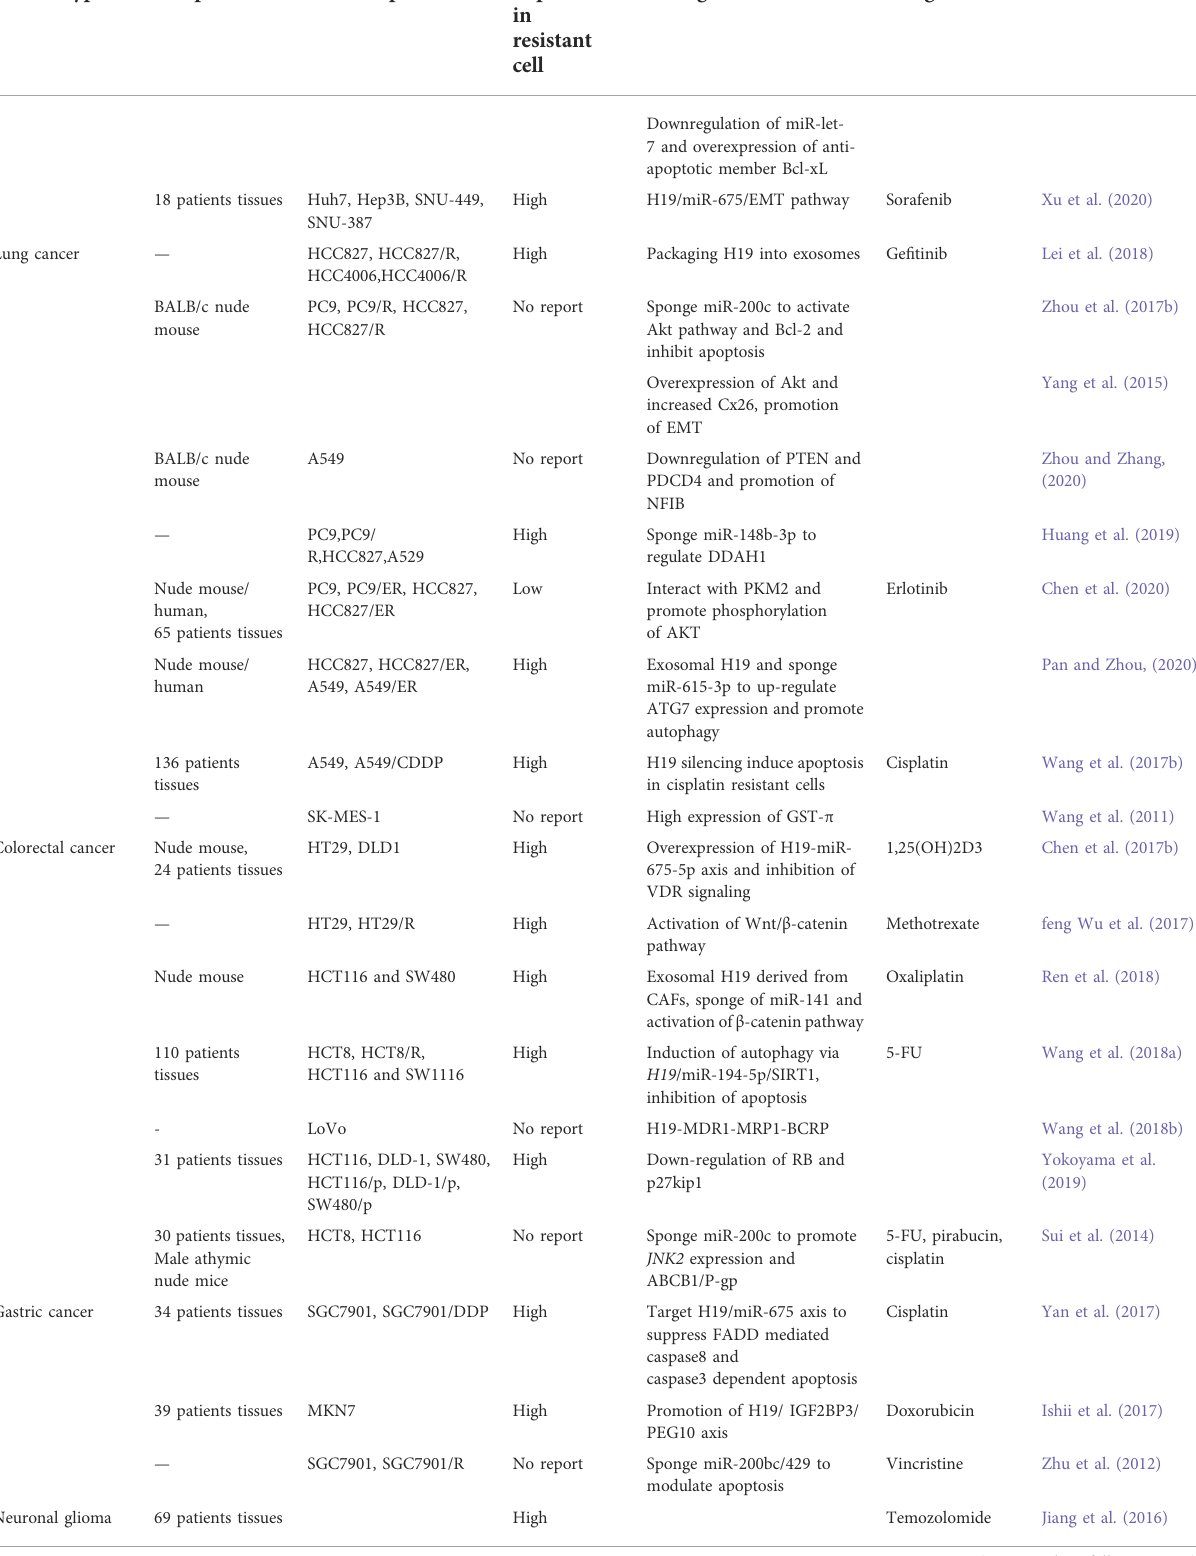
TABLE 1 ( Continued ) Summary the drug resistance mechanisms to human cancers via